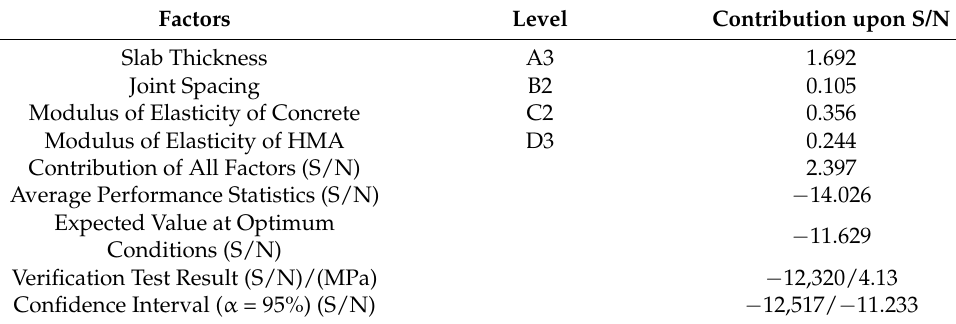
Table 11. Performance estimations